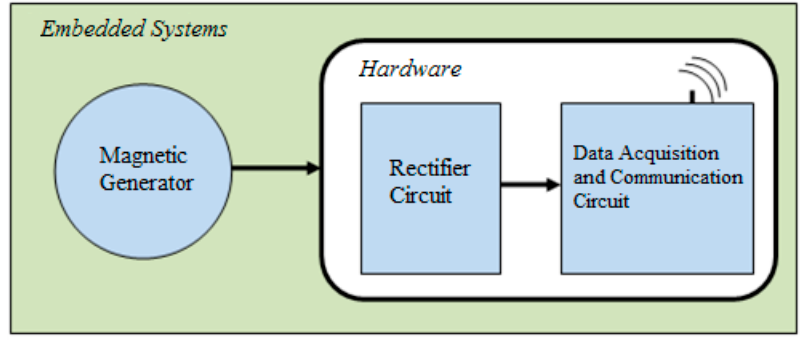
Figure 1. Embedded System Block Diagram.